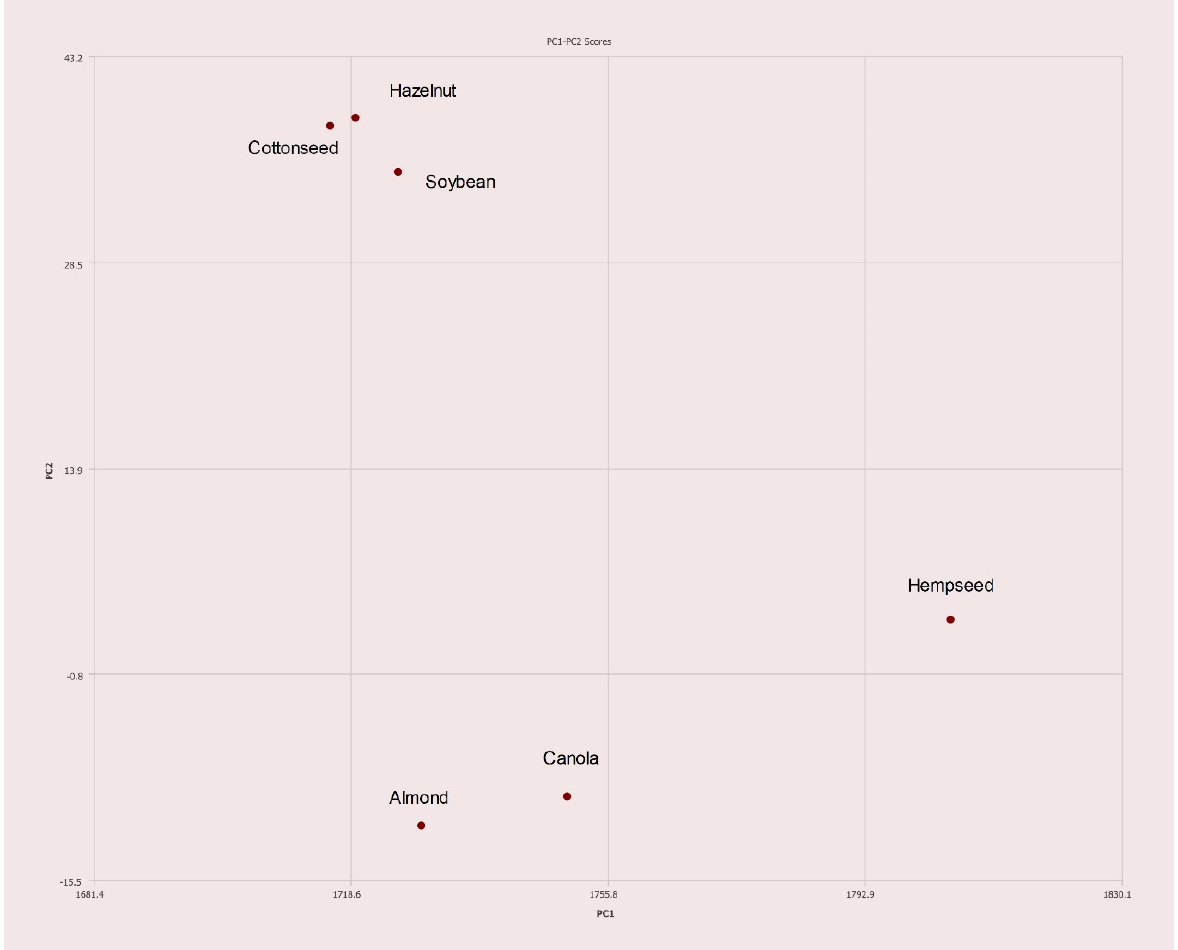
Figure 4. PC1–PC2 plot expansion of congested region in Figure 3.